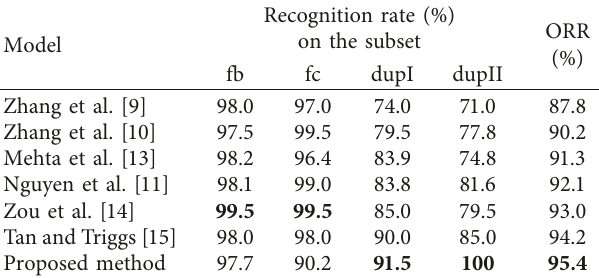
Table 3: Comparison results of different face recognition methods with POEM